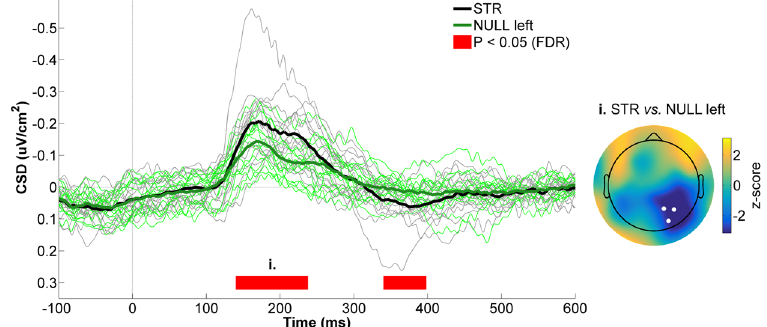
Figure 5. CSD activity recorded at the right parietal ROI for STR vs . NULL left. The black and green waveforms respectively represent CSD activity for STR and NULL left. The thin waveforms represent individual participant data, whereas the thick waveforms represent the mean CSD activity across participants. The red line highlights the time bins showing statistically significant differences between STR and NULL left ( p ≤ 0.05, FDR-corrected). Time “0 ms” corresponds to movement onset. The scalp map represents the statistical z-scores across electrodes for CSD activity between STR and NULL left during the significant time window (i., 140–240 ms). The electrodes that make up the right parietal ROI (P2, P4 and PO4) are highlighted in the scalp